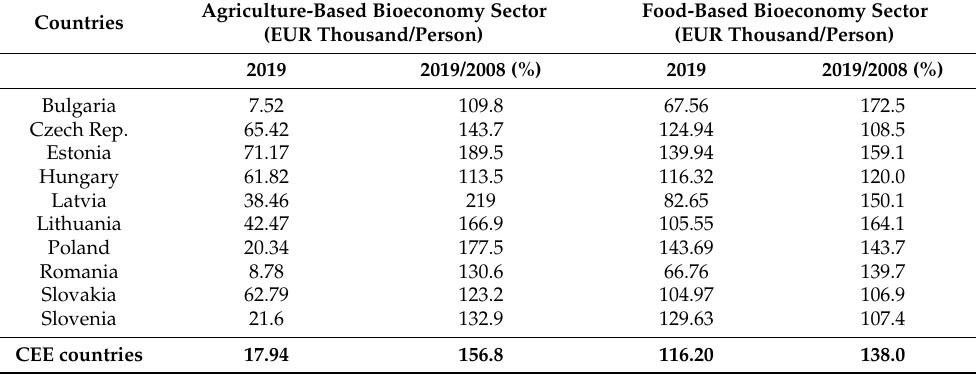
Table 5. Productivity—agriculture- and food-based bioeconomy sector.